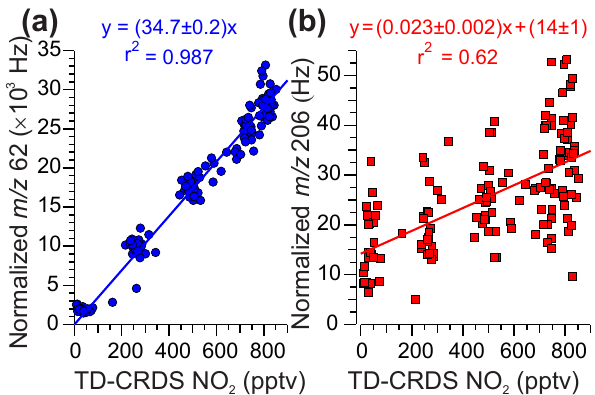
Figure 3. Calibration of CIMS response factors against TD-CRDS operated with its inlet heated to 120 ◦ C and without